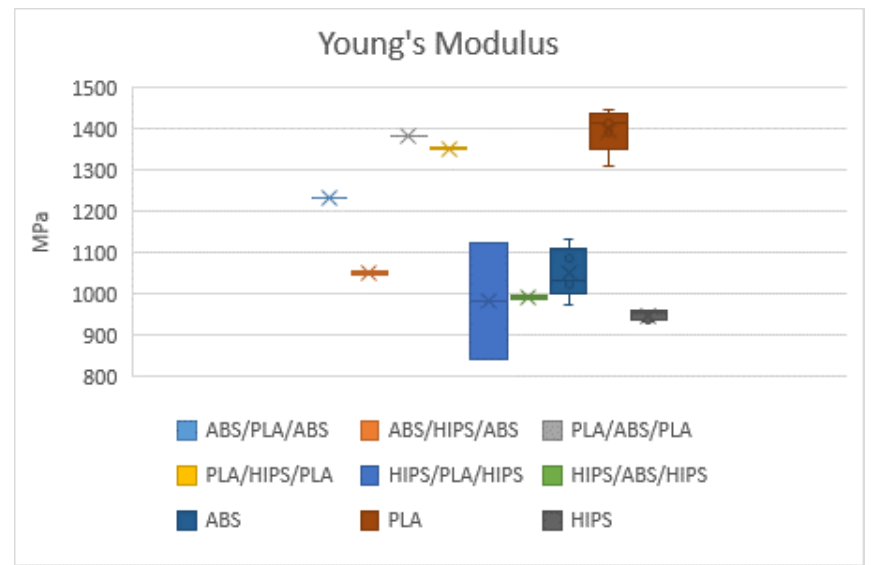
Figure 6. Mean Young’s modulus of all specimen tested.